Question: Provide a one-line summary of what is displayed.
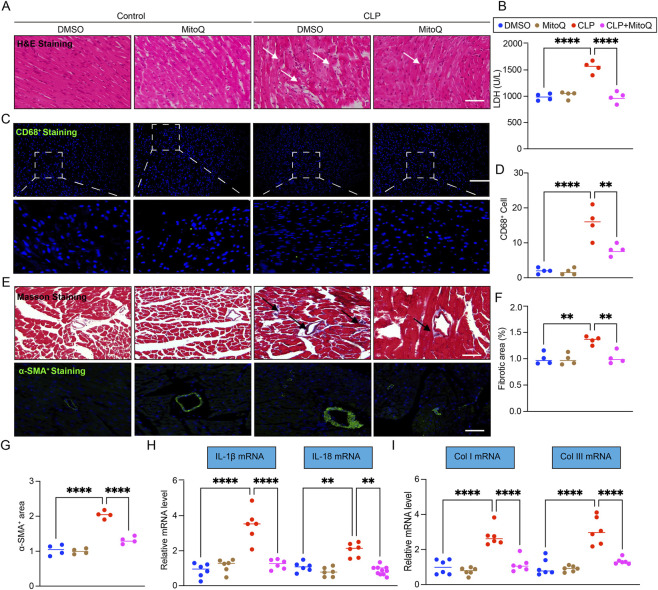
Answer: MitoQ rescues sepsis-induced cardiac inflammation and fibrosis. (A) H&E staining of heart tissues from each group (scale bar = 50 μm). (B) Serum LDH levels in each group (n = 4). (C,D) Immunofluorescence staining of CD68 (n = 4, scale bar = 50 μm); quantification of CD68 + cells (right, n = 4). (E–G) Masson’s trichrome and α-SMA immunofluorescence staining (n = 4, scale bar = 50 μm), with quantification of α-SMA + area. (H,I) RT-PCR analysis of IL-1β, IL-18, collagen I, and collagen III mRNA levels (n = 6). The results are expressed as the mean ± SD. ** p < 0.01, *** p < 0.001, and **** p < 0.0001.